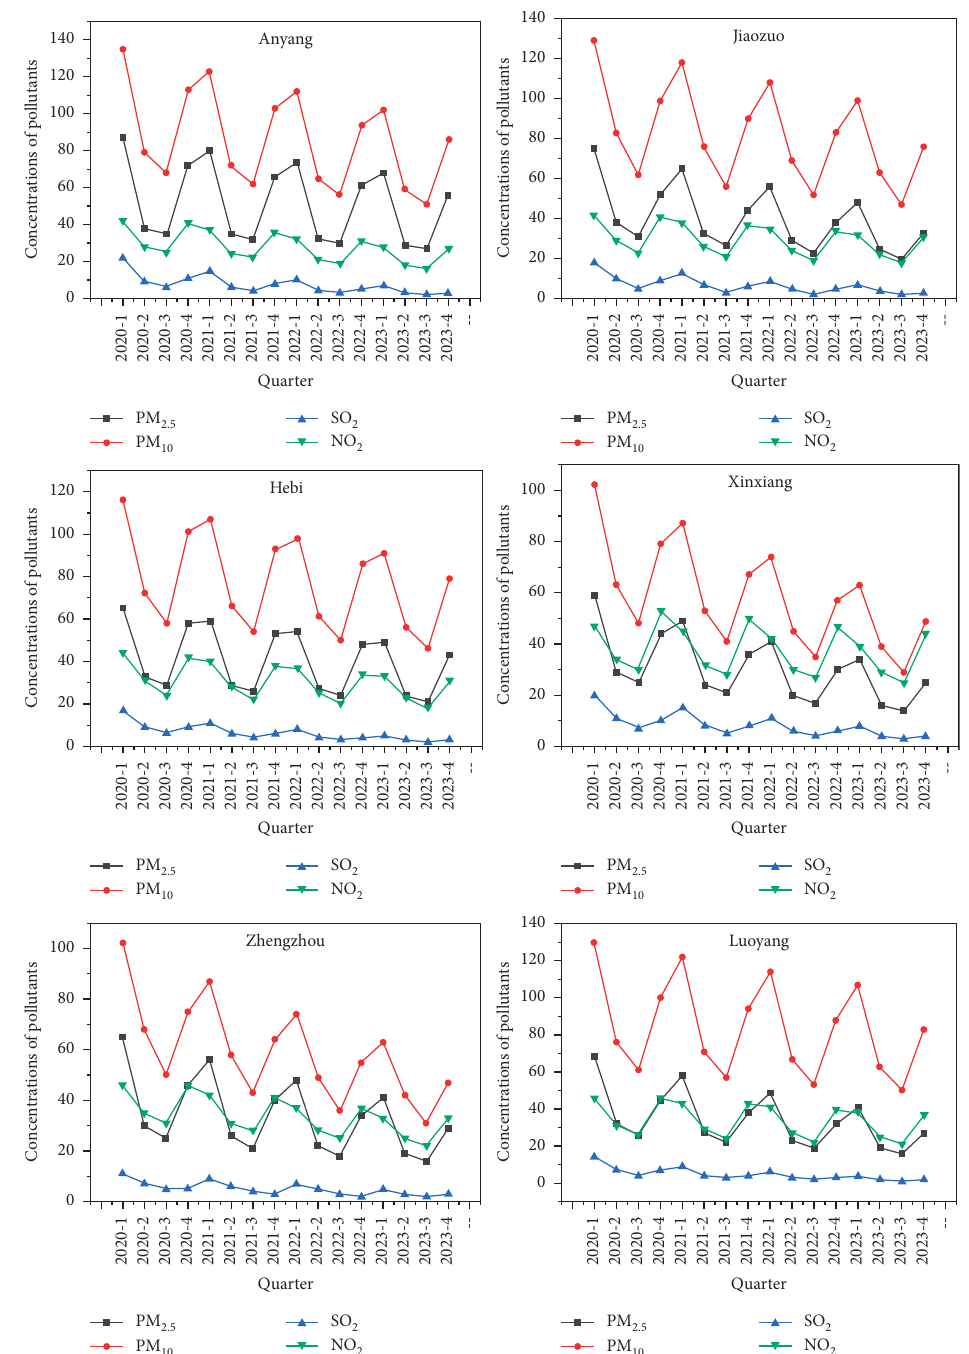
Figure 2: The predicted concentrations of four pollutants in six cities in Henan Province. Table 5: Quality levels and corresponding concentration limits of PM Pollutants Level 1 (unit: μ g/m 3